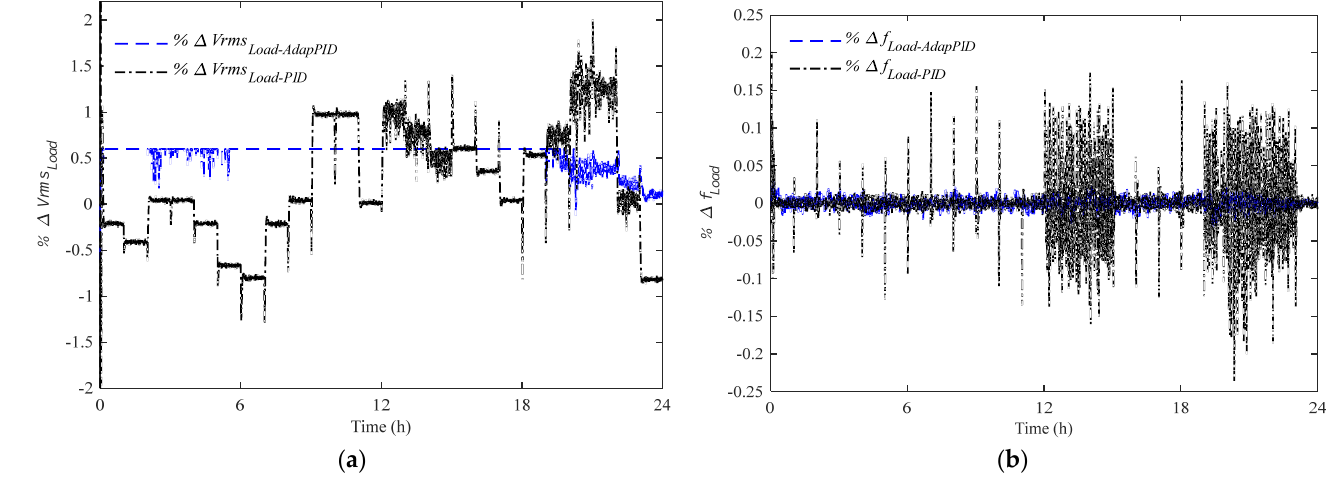
Figure 9. % change in load ( a ) RMS voltage ( b ) Frequency. Table 1. Reference power transfer levels in kW for respective vehicles and hours.